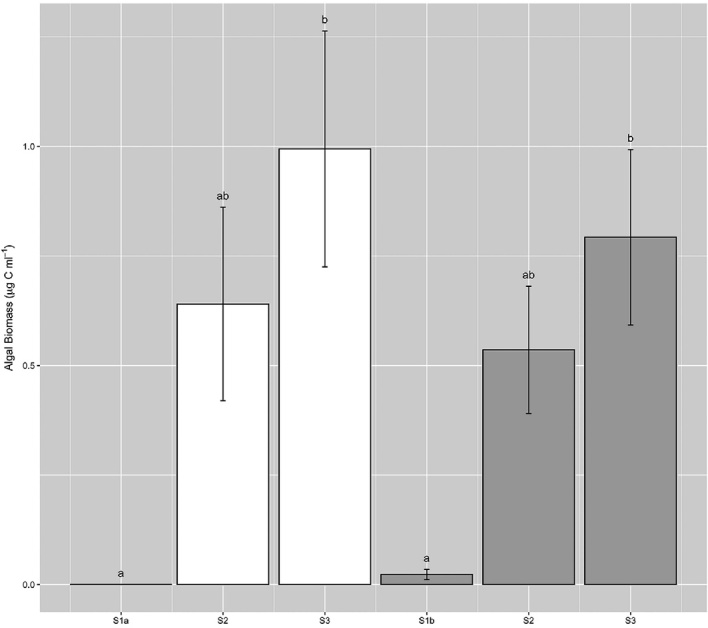
Ice algal biomass within surface ice assessed across sampling sites during transect 1 (white bars) and transect 2 (grey bars) (mean ± SE, n = 10). Lower-case letters denote homogenous subsets determined from 1-way ANOVA analysis of algal biomass ∼ site per transect (Transect 1, F2,27 = 7.07, P < 0.01; Transect 2, F2,27 = 8.40, P< 0.01). Separate 1-way ANOVA was performed per transect given the assessment of different sites (S1a/S1b) between transects.